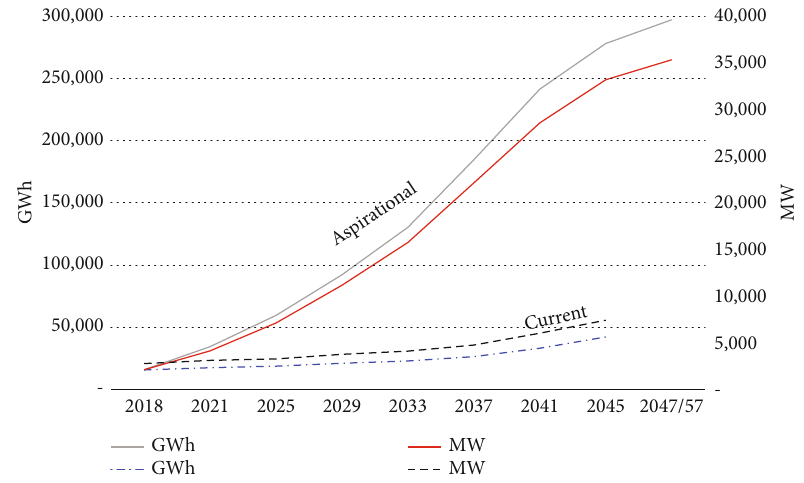
Figure 1: Electricity demand requirements for 40-year long-term economic growth [32].